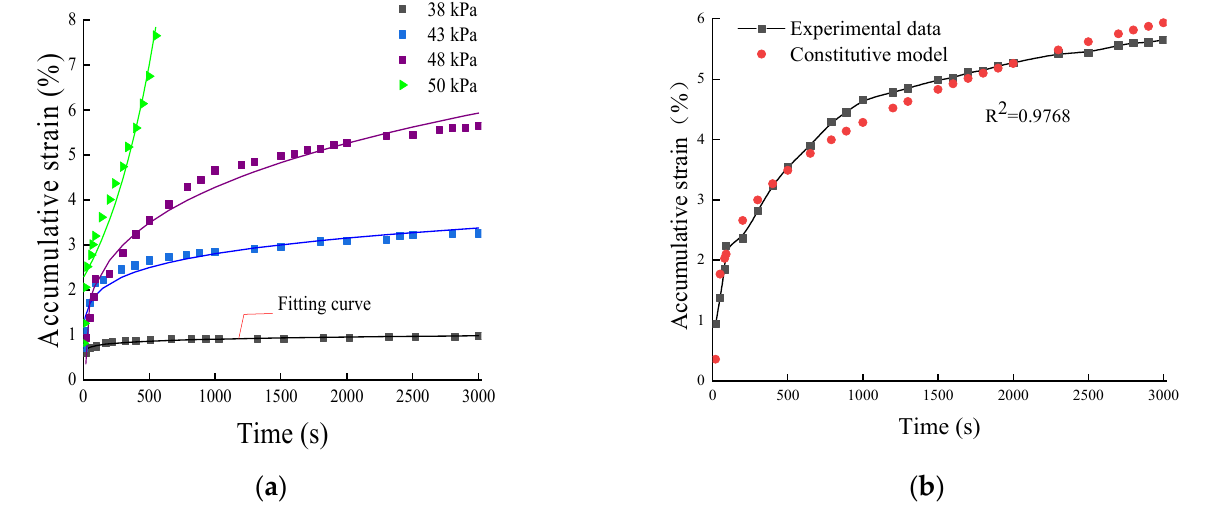
Figure 13. ( a ) Predication of dynamic constitutive model in Tian Jin soft clay; ( b ) Comparison between experimental data and fitting results ( σ _3 = 100 kPa, σ _1/ σ _3 = 0.48).